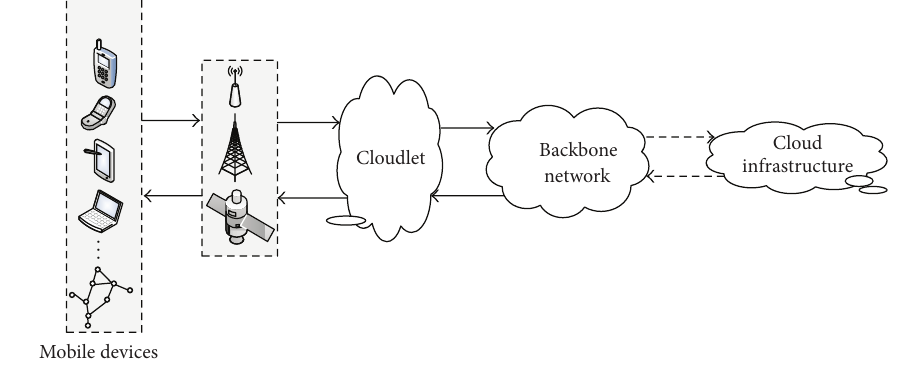
Figure 2: The Cloudlet architecture.